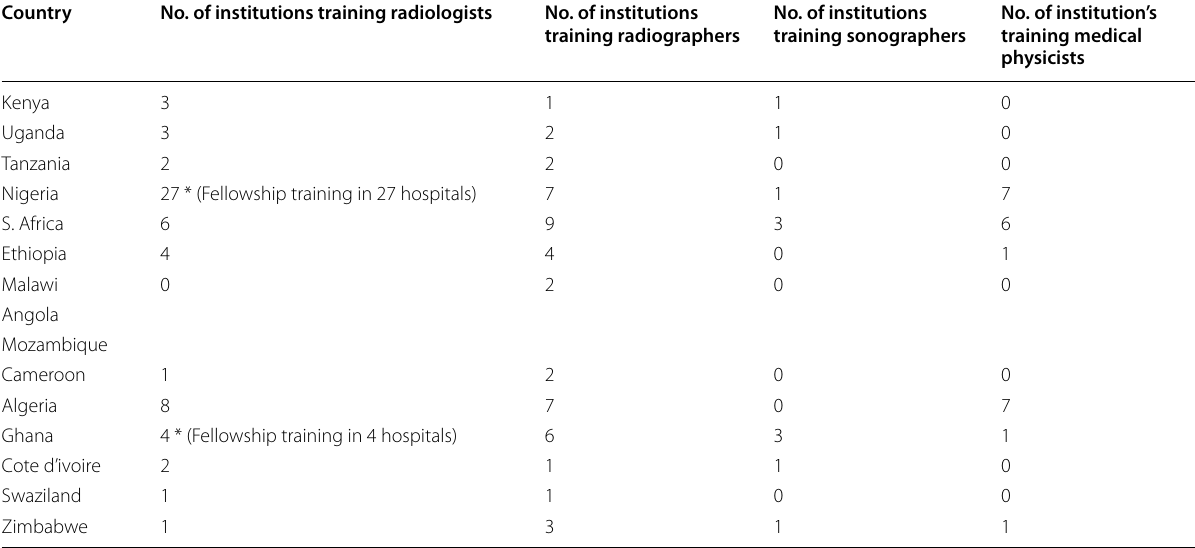
Table 2 Institutions for training of imaging personnel and medical physicists in Africa Country No. of institutions training radiologists